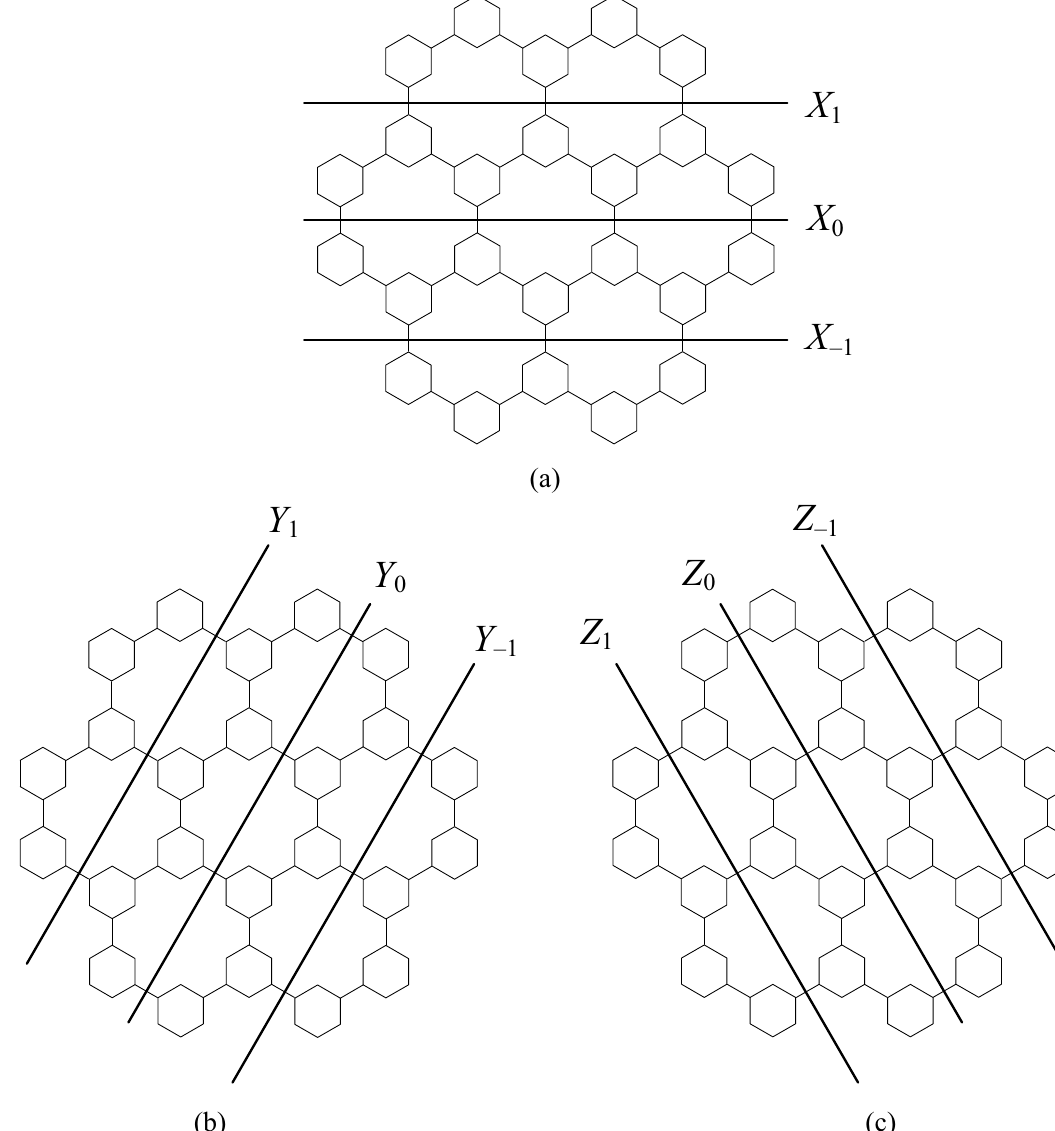
Figure 2: Edge cuts made up of edges perpendicular to ( a ) X direction, ( b ) Y direction, and ( c ) Z